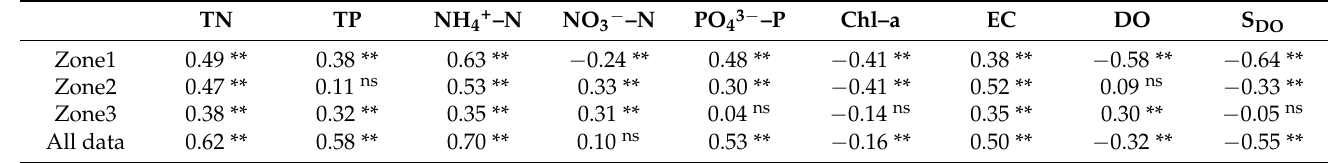
Table 1. Spearman’s rank correlation coefficient between pCO 2 and water parameters a